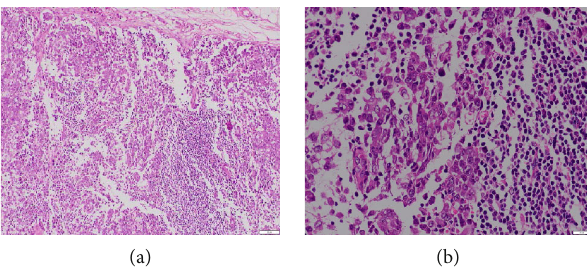
Figure 4: Photomicrographs showing tumor in fi ltration in the submandibular lymph node: dedi ff erentiated area with in fi ltrated neoplastic cells ((a) hematoxylin eosin); higher power view of the in fi ltrated lymph node showing nuclear pleomorphism and hyperchromatism of the neoplastic cells ((b) hematoxylin eosin).